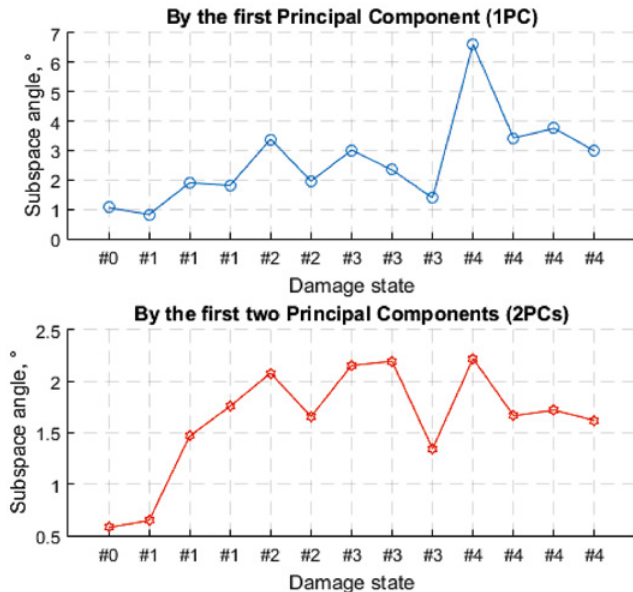
Figure 7. Damage indexes by subspace angles, the frequency of excitation is nearby f